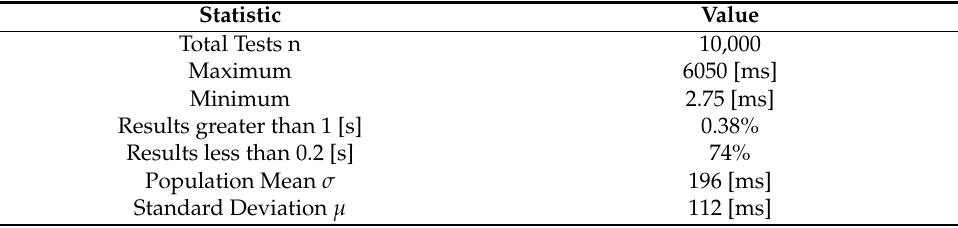
Table 5. Server input/output response time test